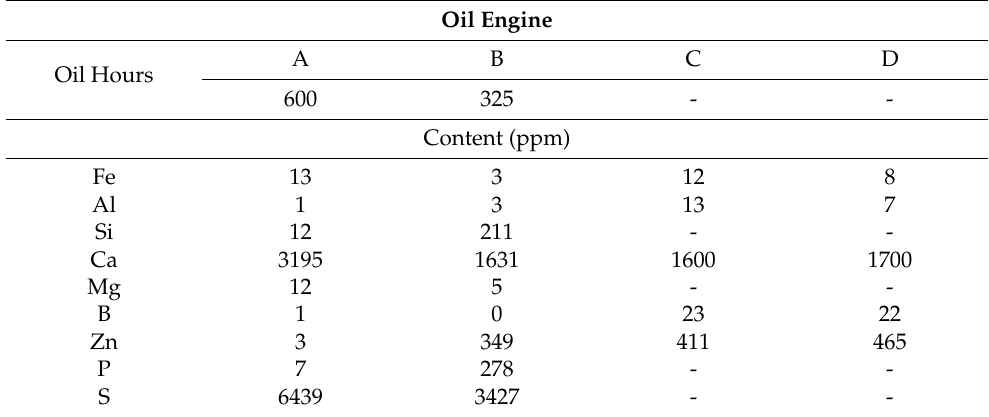
Table 4. Engine oils